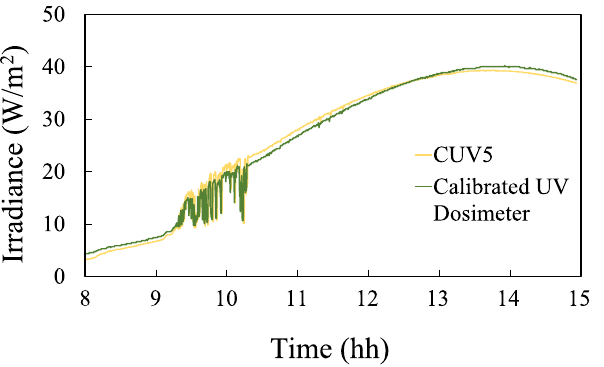
Figure 13. Irradiance (W/m 2 ) measured on 30 August 2021: proposed device (green) vs. CUV5 radiometer (yellow).